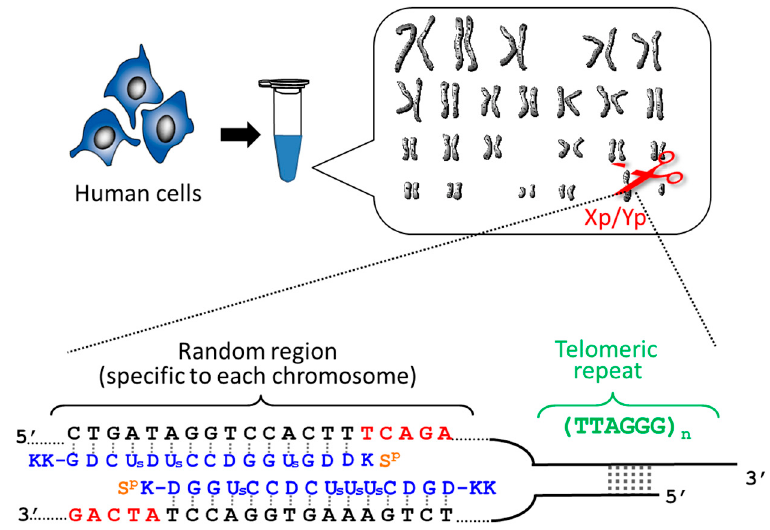
Figure 1. Clipping of individual telomere from each of the chromosomes in human cells. ARCUT is designed to cut the site where the telomeric repeats (TTAGGG)n terminate and the sequence is specific to each telomere (Xp/Yp here).